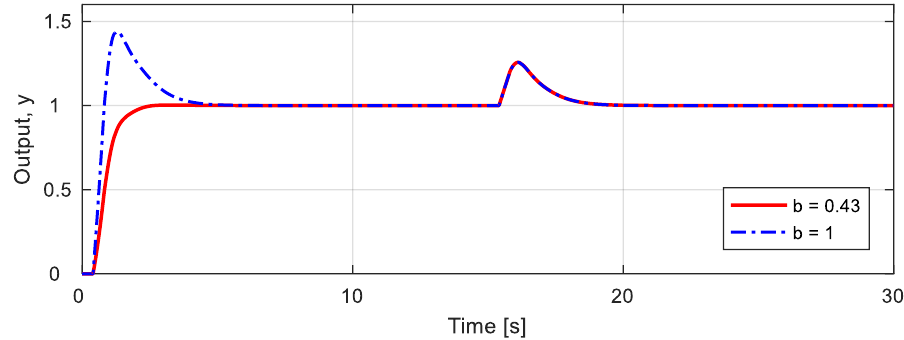
Figure 10. Unit step responses with and without set-point filter for nominal process 𝑃 1 . Table 10. Effect of set-point filter for nominal process 𝑃 1 .